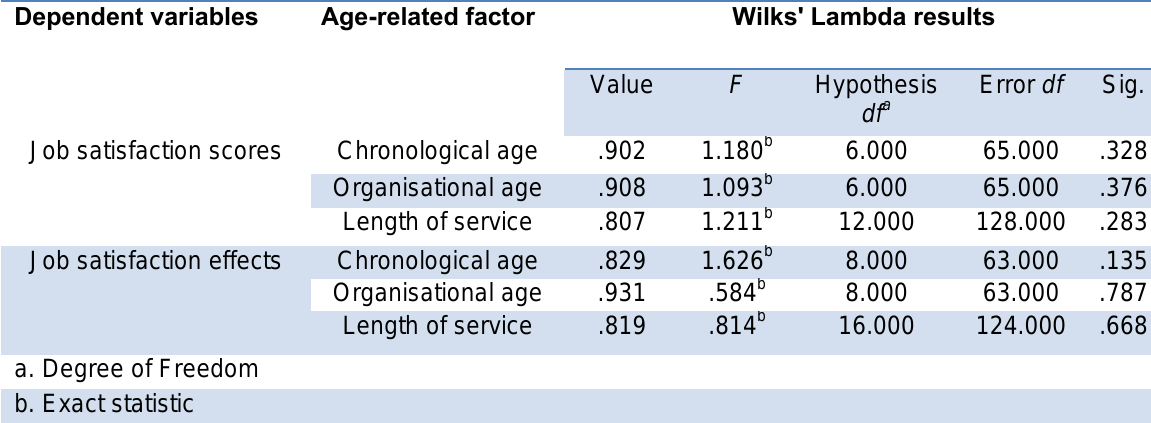
Table 7: Results of comparing job satisfaction scores/effects between different categories of age-related factors (chronological age, organisational age and length of service) as defined in Table 2 Dependent variables Age-related